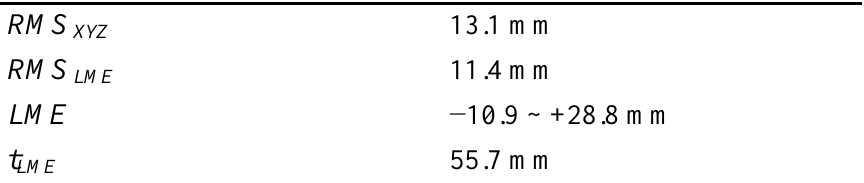
Table 4. Results of measurements.